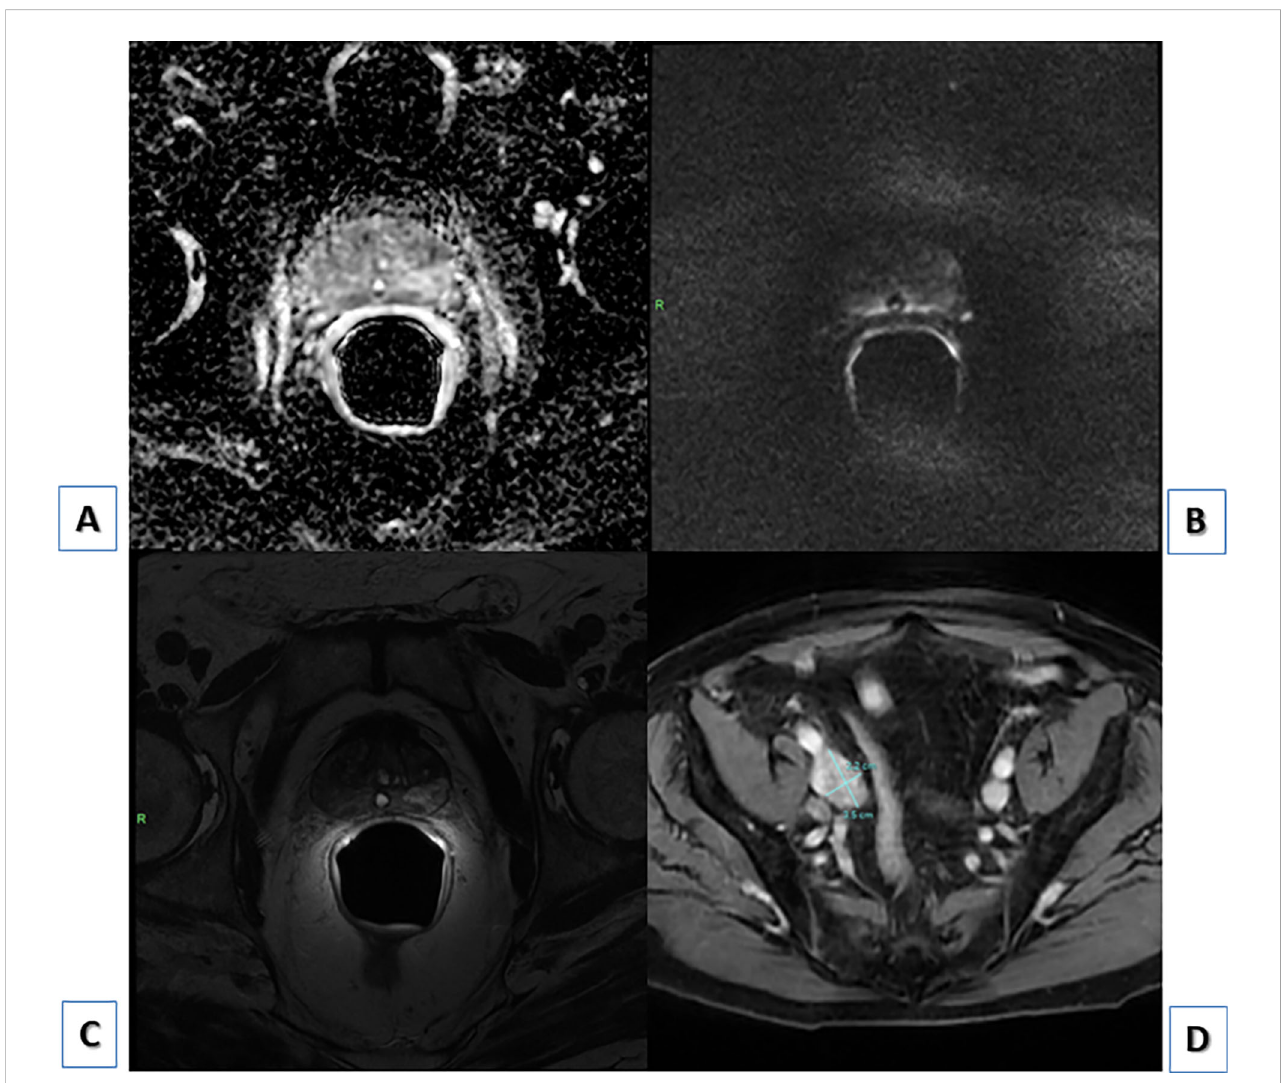
FIGURE 2 (A) PI-RADS 2 prostate gland at mpMRI, ADC, axial; (B) PI-RADS 2 prostate gland at mpMRI, DWI, axial; (C) PI-RADS 2 prostate gland at mpMRI, T2, axial; (D) external iliac enlarged lymph node showing contrast-enhancement at mpMRI, T1 LAVA FLEX sequence,